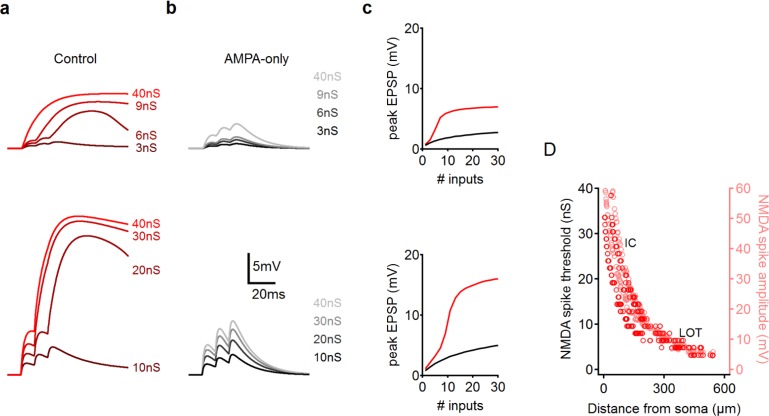
NMDA spikes in PCx pyramidal neurons: modeling results.(a) Representative examples of focal synaptic stimulation at the LOT (top) and the IC (bottom) regions. (b) AMPAR only stimulation, same locations. Colors code synaptic strength as labeled. (c) Peak somatic EPSP as a function of synaptic conductance for the two dendritic locations, LOT (top) IC (bottom). (d) Dependence of NMDA spike threshold (red) and NMDA spike amplitude (pink) on the distance of the stimulation site from the soma.